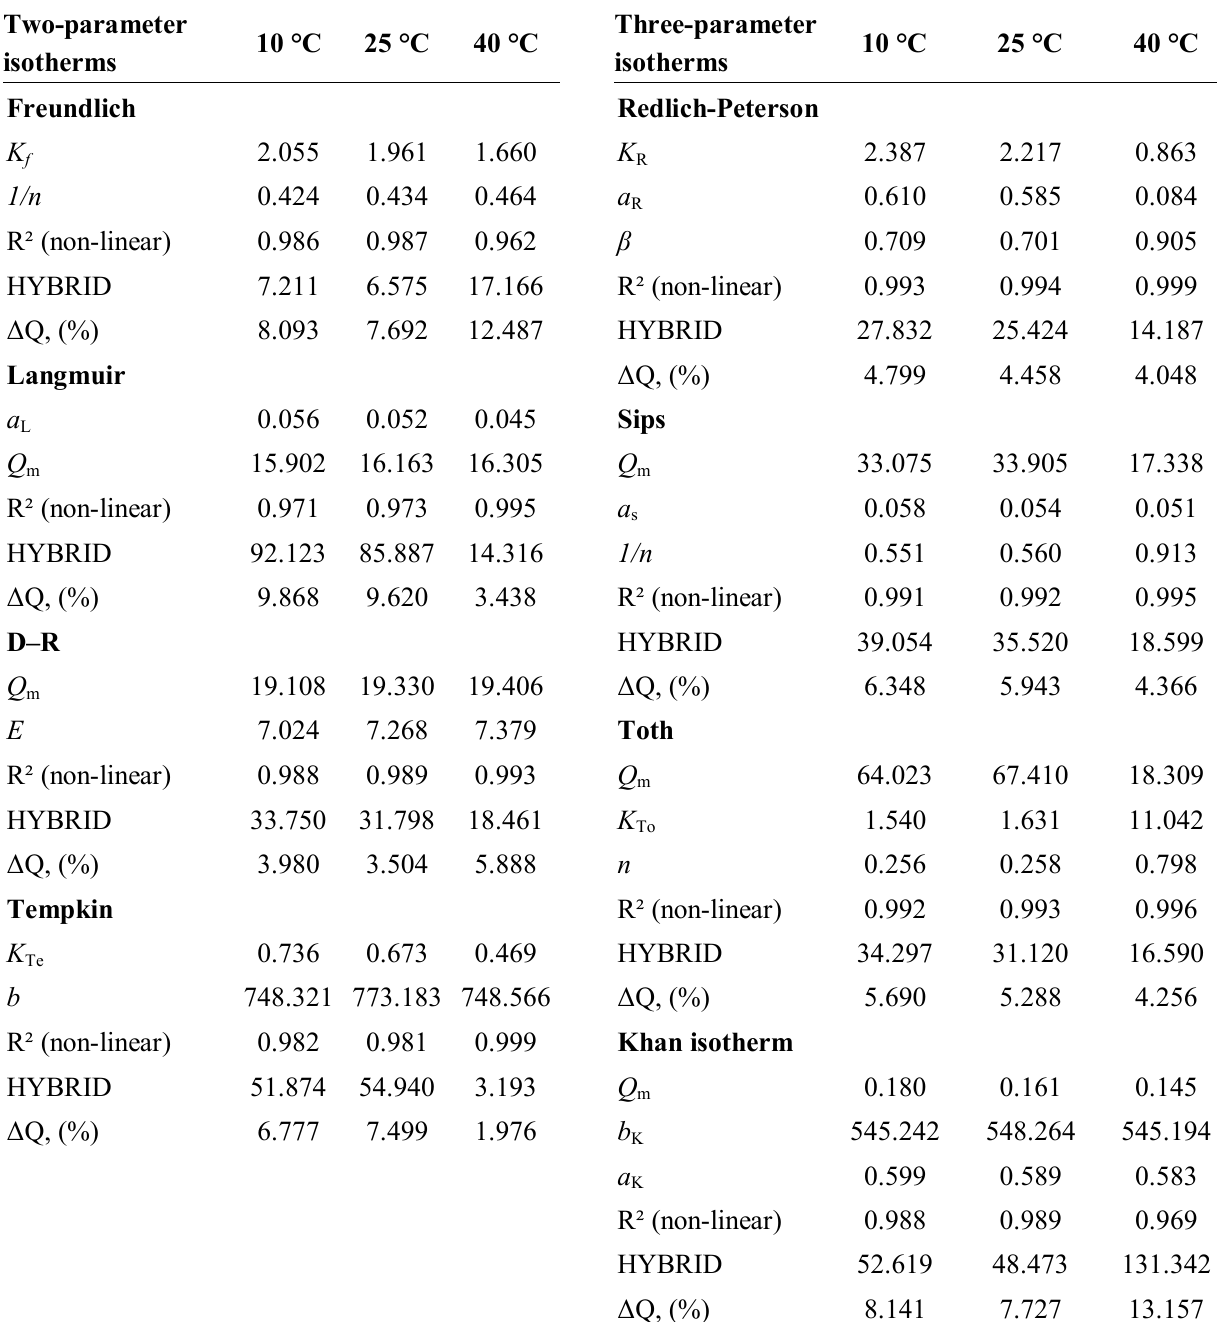
Table 2. Comparison of two-parameter and three-parameter isotherms for different temperatures.